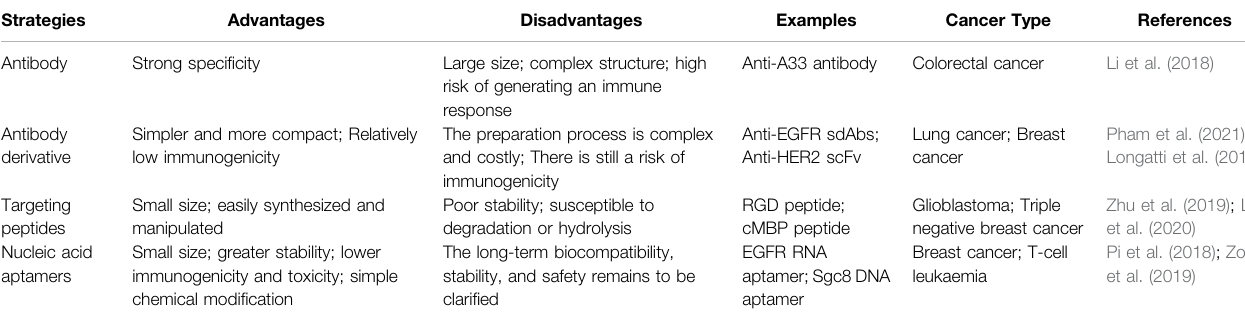
TABLE 2 | Strategies for enhancing targeting of